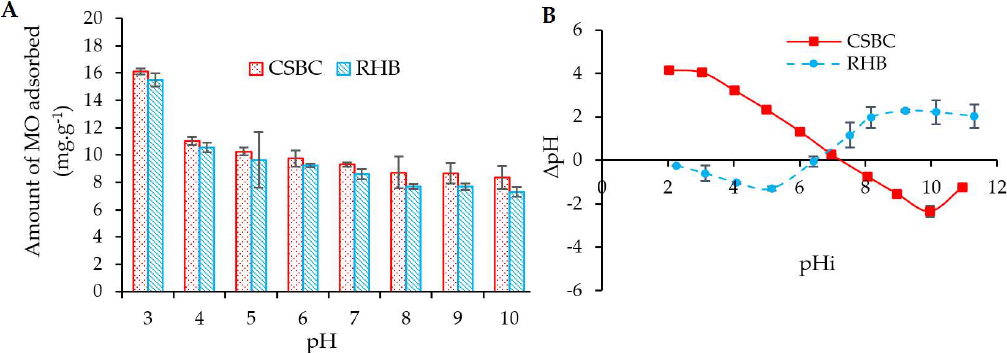
Figure 5. Effect of pH on MO adsorption ( A ) and pH pzc of CSBC and RHB ( B ).